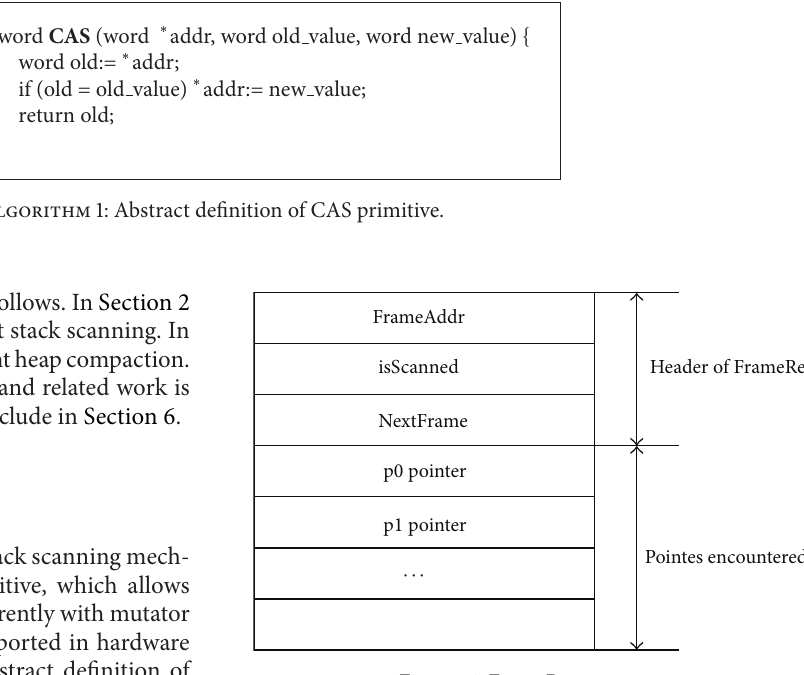
Figure 1: FrameRec